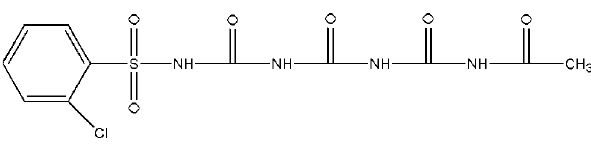
FIGURE 6. 1[2-chlorobenzene-1-sulfonyl]-7-acetyltriuret.